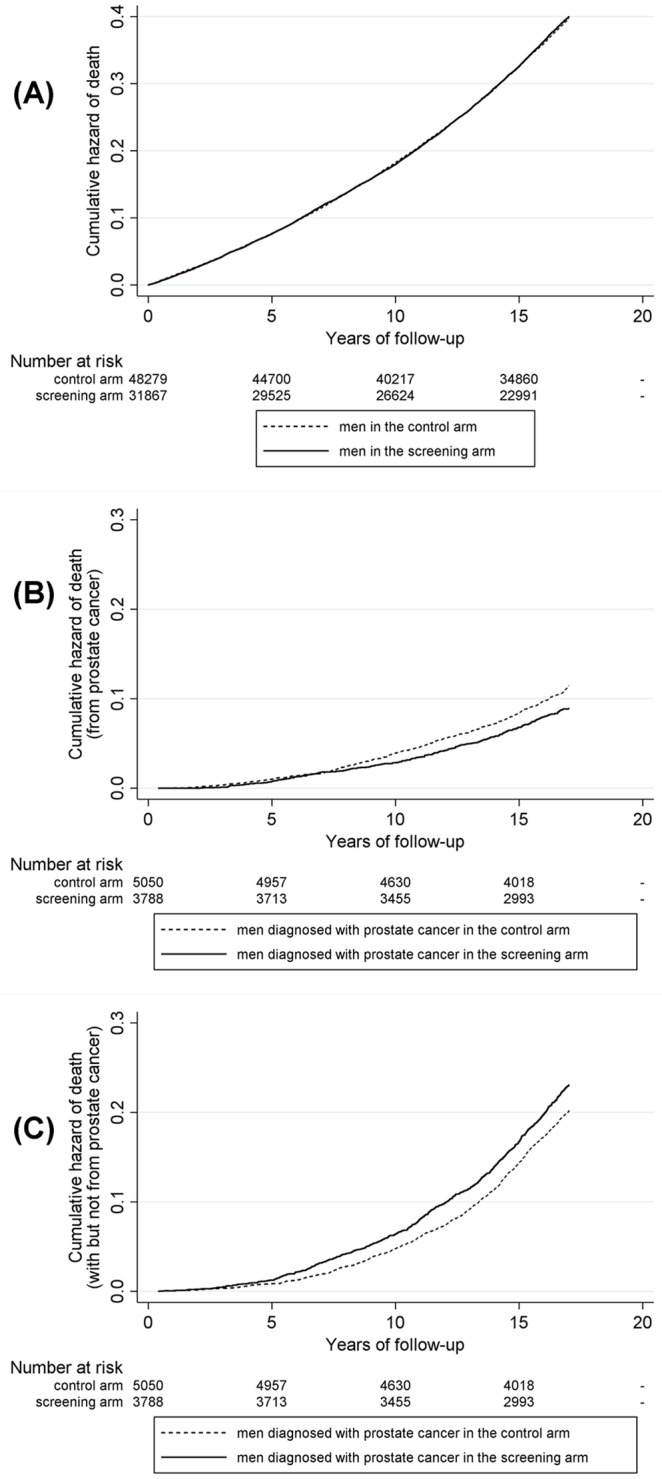
Nelson–Aalen estimates of risk of dying, from point of randomisation.Panel (A): Death from any cause, during follow-up, by trial arm. Panel (B): Death from prostate cancer, for men diagnosed during follow-up, by trial arm. Panel (C): Death with, but not from, prostate cancer, for men diagnosed during follow-up, by trial arm.